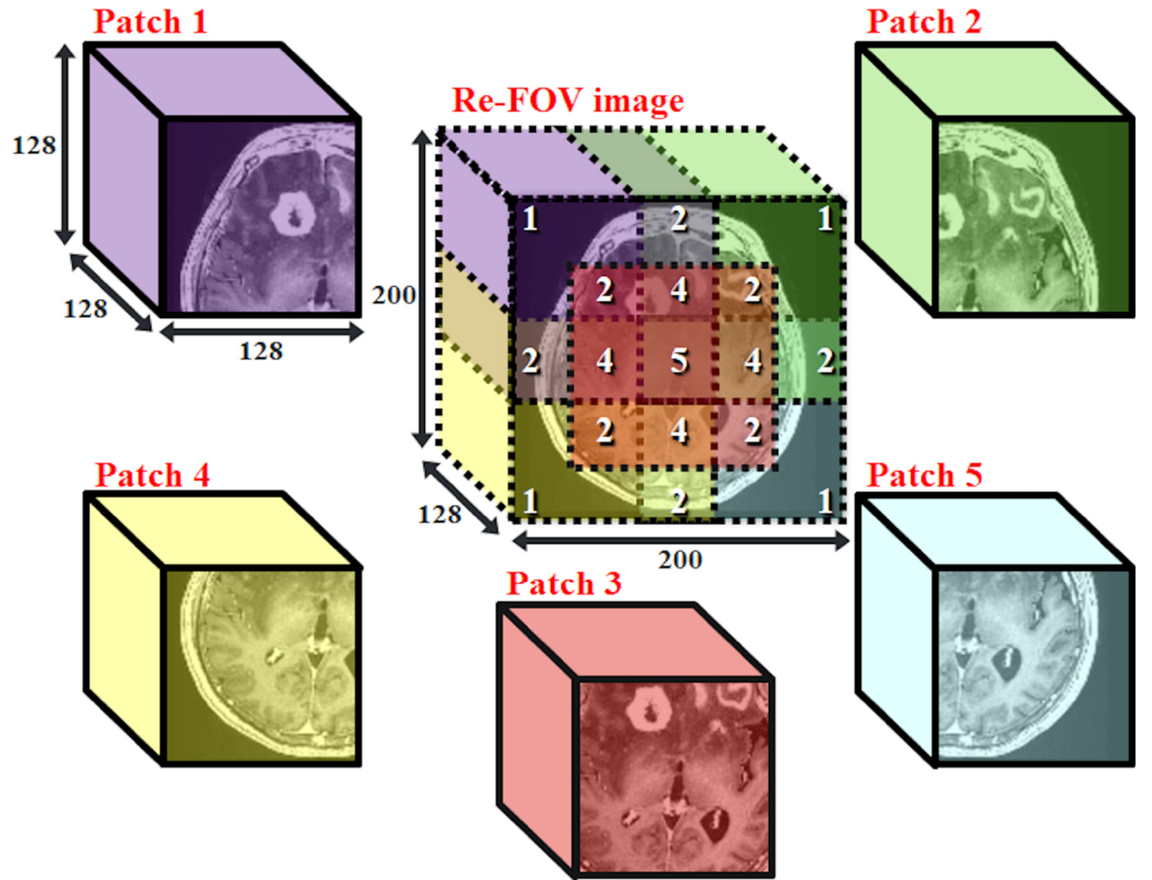
Figure 2. The correlation between five patch and re-FOV image. Patches p1~p5 have their own spatial locations at the coordinates of the re-FOV image. In this paper, we call the collection of the same patch from all subjects the patched dataset.